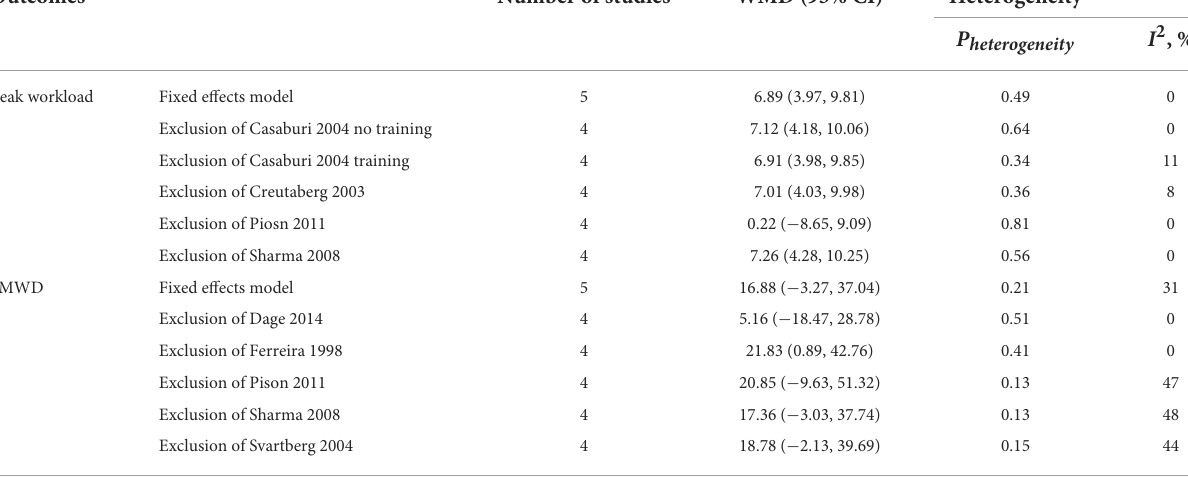
TABLE 3 Sensitivity analysis of included randomized controlled trials for the outcome of peak workload and 6MWD.